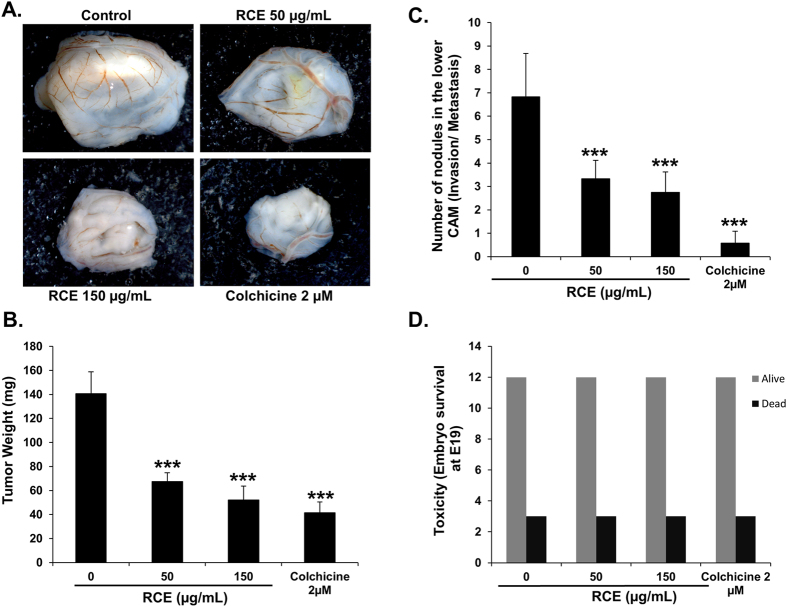
Anti-tumor growth and anti-metastatic activity of Rhus coriaria on breast tumor in chick embryo chorioallantoic membrane model system.(A) MDA-MB-231 (1 × 106) cells were grafted on the CAM of 10 day (E10) chick embryo. Tumors were treated every 48 h with RCE as described in Materials and Methods. At E19, tumors were collected and weighted. (B) Quantification of tumor weight in vehicle (ethanol), colchicine and indicated concentrations of RCE-treated chick embryo. (C) Anti-metastatic effect of Rhus coriaria. Quantification of nodules observed in the lower CAM of chick embryo treated with vehicle (ethanol), colchicine or indicated concentrations of RCE. Columns represents mean; bars represents SEM. ***significantly different at p < 0.0005. (D) Toxicity screening of RCE on chick embryos. Toxicity was evaluated by comparing the number of dead embryos in control, colchicine- and RCE-treated embryos.